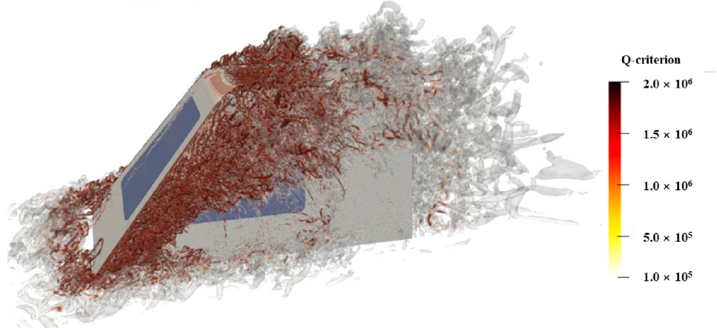
Figure 7. Instantaneous iso-surfaces of Q-criterion (at t = 2.8 s).